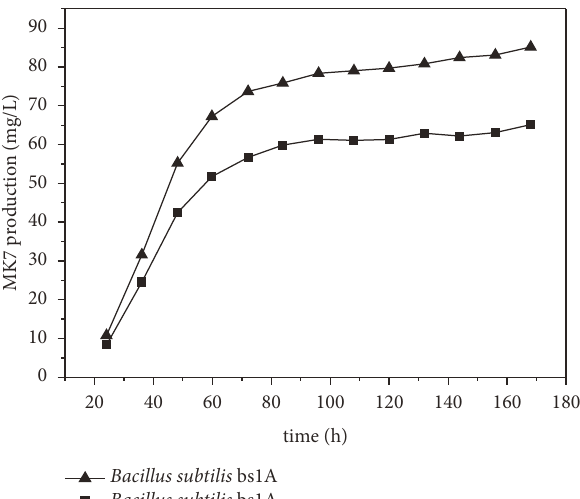
Figure 4: Changes in the concentration of MK-7 for Bacillus subtilis natto and Bacillus subtilis BslA in a 20 L biofilm reactor at 40 ° C, pH 8.0, 450rpm, and 2.0 vvm.